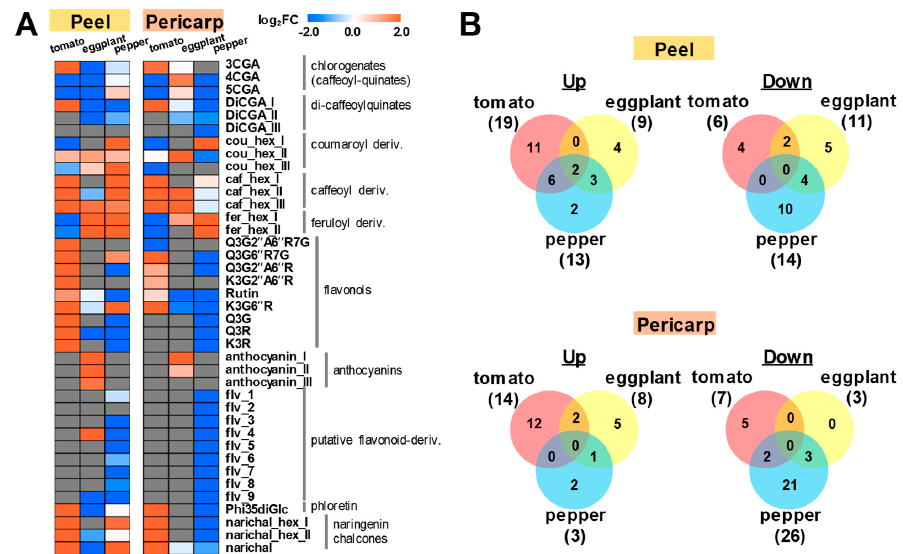
Figure 2. Metabolite profiling of major polyphenolic compounds between fruit tissues among three major solanaceous crops. ( A ) metabolic shift during fruit ripening (log 2 FC(mature / immature)) in peel and pericarp of tomato, eggplant and pepper fruits is presented. ( B ) venn’s diagrams show conserved metabolic changes within and between fruit tissues among three solanaceous crops. Metabolites which are commonly up- (>2.0) or down-regulated (<0.5) are shown. MeV software